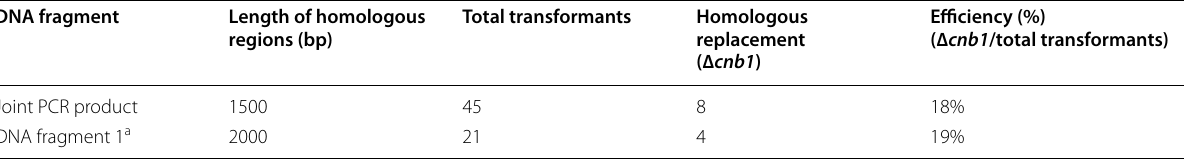
a Data are cited from Matsumoto et al.(Matsumoto et al.